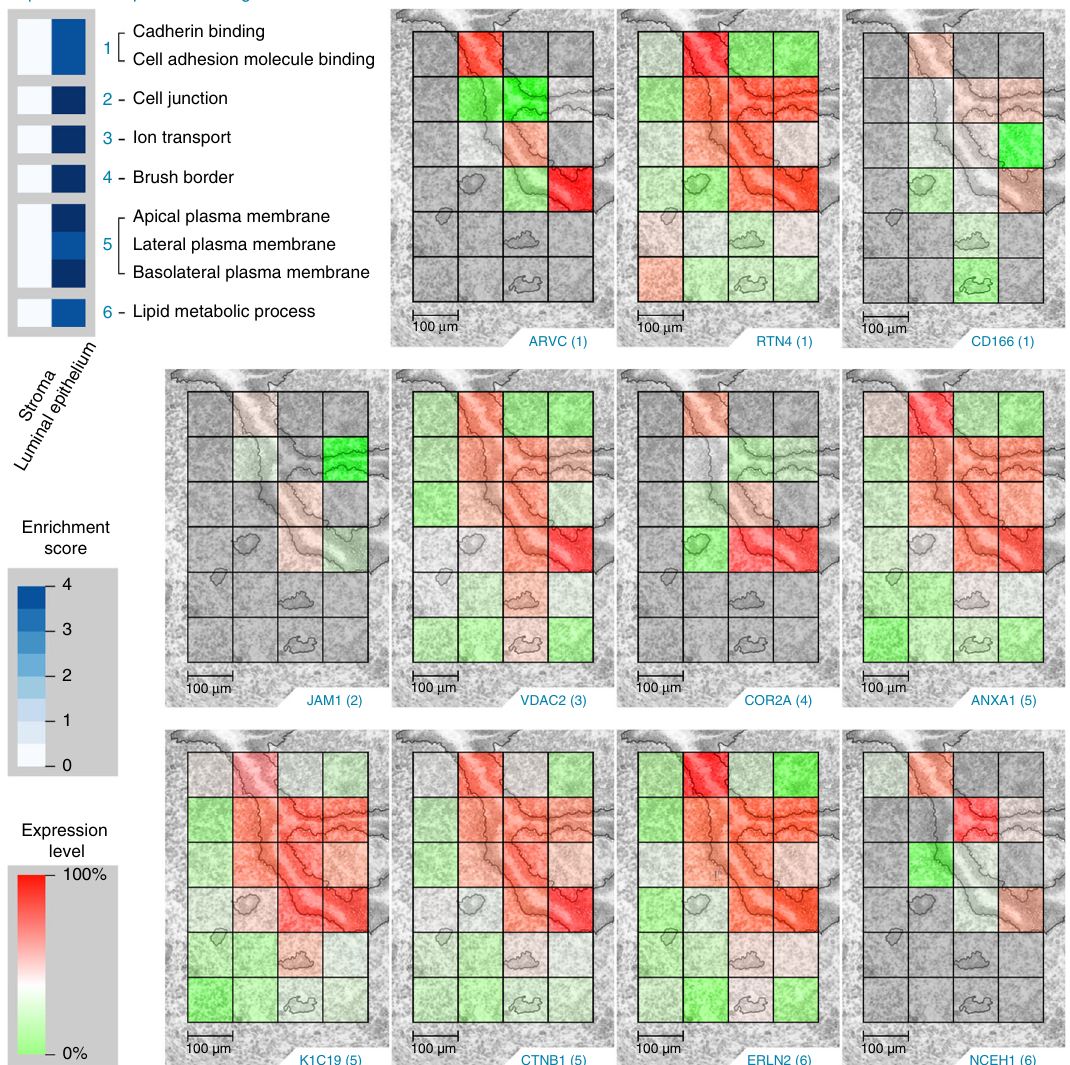
Fig. 4 The top six luminal epithelium (LE) Gene Ontology categories (top, left) enriched in the statistically signi fi cant (Tukey-adjusted ANOVA or a Holm-adjusted g test, p value <0.05) proteins from the dominant cell population study and the corresponding protein images. (1) Armadillo repeat protein deleted in velo-cardio-facial syndrome homolog (ARVC), reticulon-4 (RTN4), and CD166 antigen (CD166); (2) junctional adhesion molecule A (JAM1); (3) voltage-dependent anion-selective channel protein 2 (VDAC2); (4) coronin-2A (COR2A); (5) annexin A1 (ANXA1), keratin type I cytoskeletal 19 (K1C19), and catenin beta-1 (CTNB1); (6) erlin-2 (ERLN2), a neutral cholesterol ester hydrolase 1 (NCEH1). Scale bars, 100 µ m. The authors thank PNNL Graphic Designer Nathan Johnson for preparing the fi